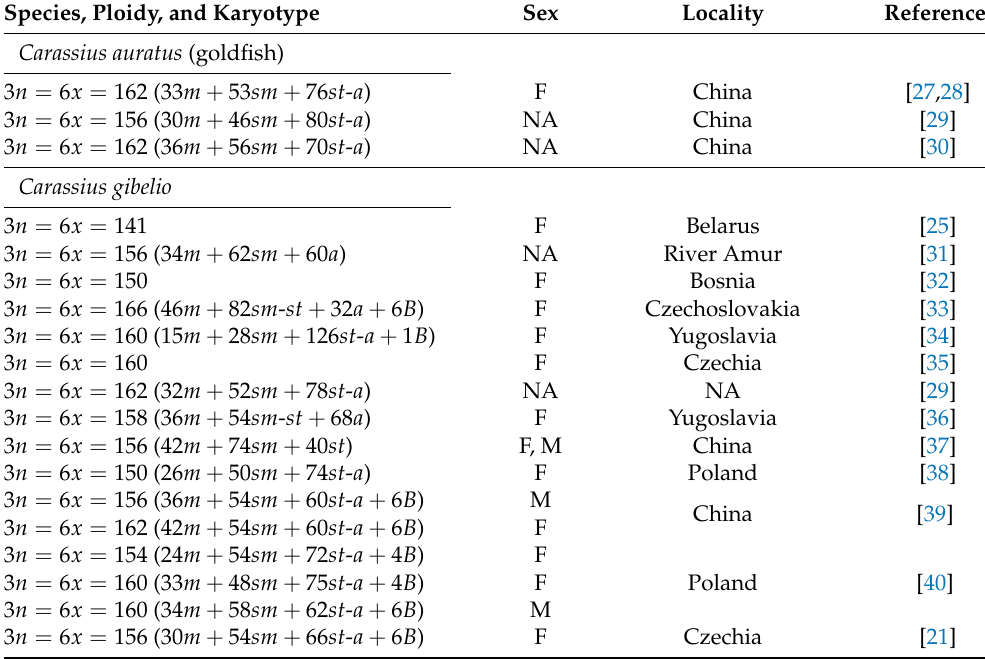
Table 1. Previously published karyotype formulas within C. auratus complex, including information about sex and locality of the investigated individuals. Karyotype data are ordered chronologically. Carassius carassius and diploid C. auratus and C. gibelio are not involved. 2 n = diploid, 3 n = triploid, 4 n = tetraploid, m = metacentric, sm = submetacentric, st = subtelocentric, a = acrocentric, B = B chromosome/microchromosome, NA = information not available, F = female, M = male. Species, Ploidy, and